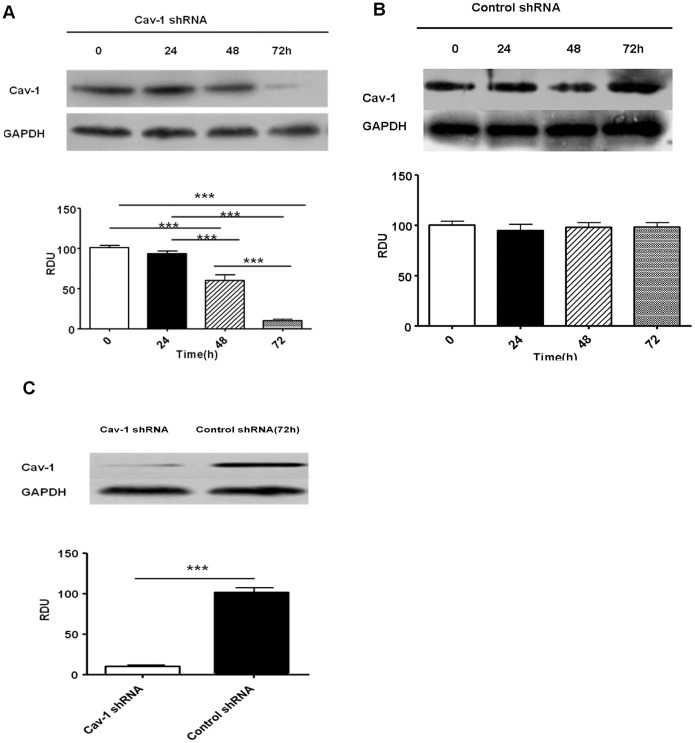
shRNA-mediated down-regulation of caveolin-1 expression in primary PMVECs.Control shRNA and Cav-1-shRNA cells were harvested and analyzed in immunoblots probed with a caveolin-1 antibody or GAPDH antibody, as shown in Figure 4. A. Caveolin-1 shRNA reduced expression of caveolin-1 obviously at the time point of 48 h(60±10%) and to minimum at 72 h (10±2%).B. Nevertheless, there was no change of caveolin-1 expression in control shRNA cells. C. Cav-1- shRNA reduced caveolin-1 expression by approximately 90% as compared with control shRNA. Values are mean±SD. *P<0.05, **P<0.01, ***P<0.001.